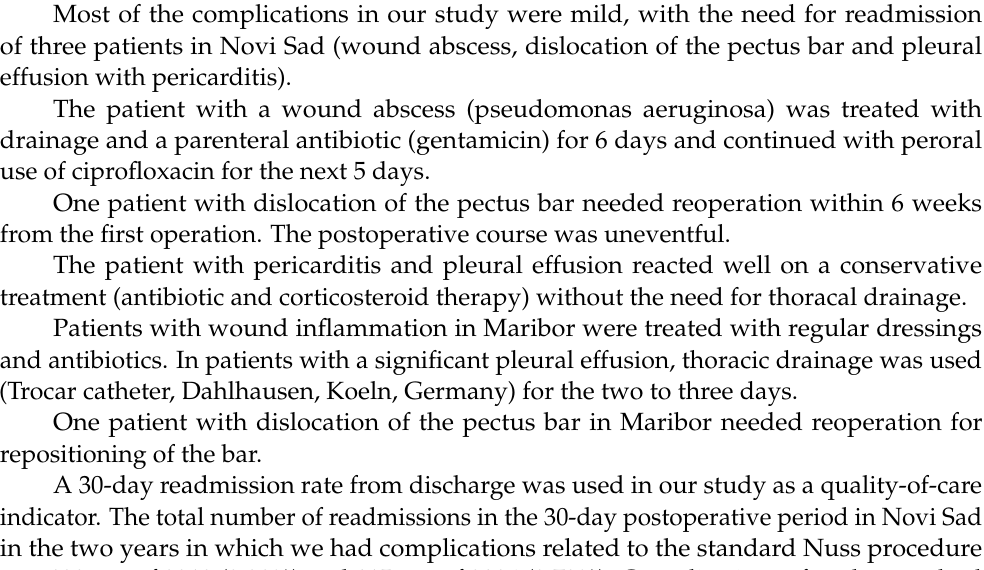
Table 3. Frequency and structure of complications in Maribor and Novi Sad.